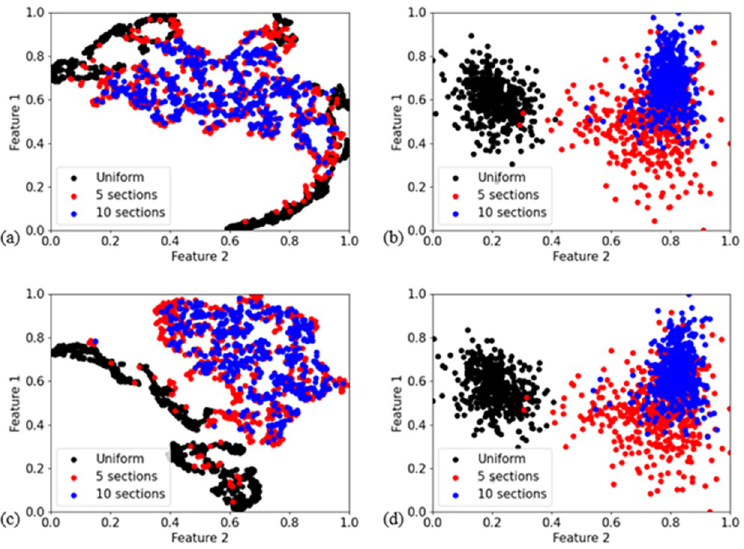
Fig 12. Data visualization by t-SNE and LDA (a) t-SNE on spectra (b) LDA on spectra (c) t-SNE on spectra injected temperature (d) LDA on spectra injected temperature.